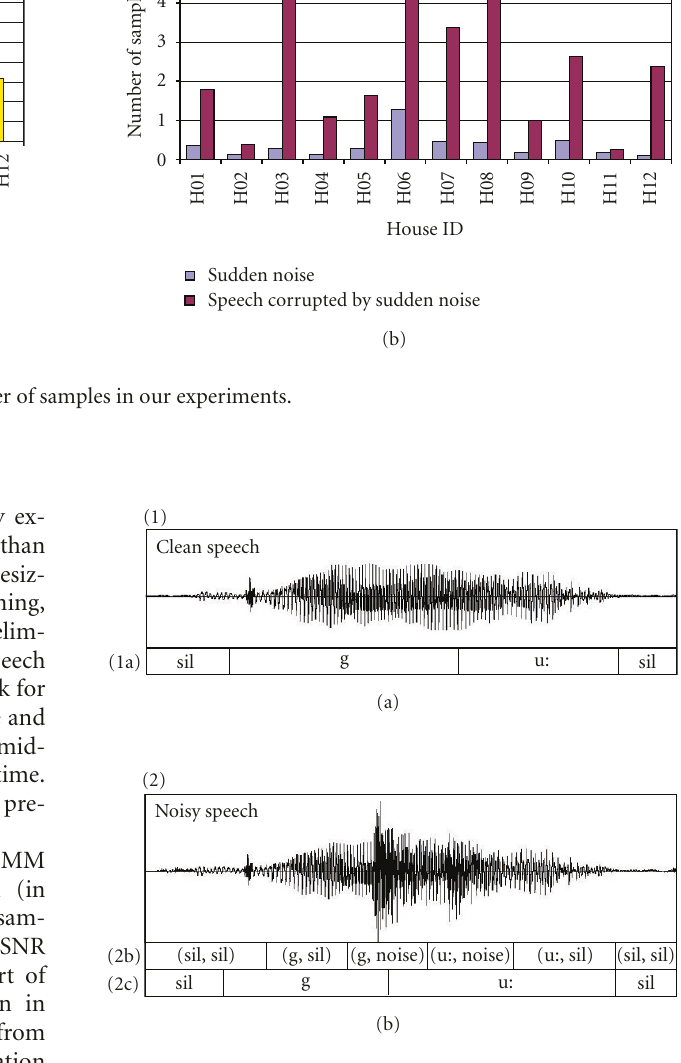
Figure 5: Segmentation for sound “gu:”. Segmentations (1a) and (2c) are given by clean-speech HMMs. Segmentation (2b) is given by FHMM, where each unit is represented by a pair of speech and noise